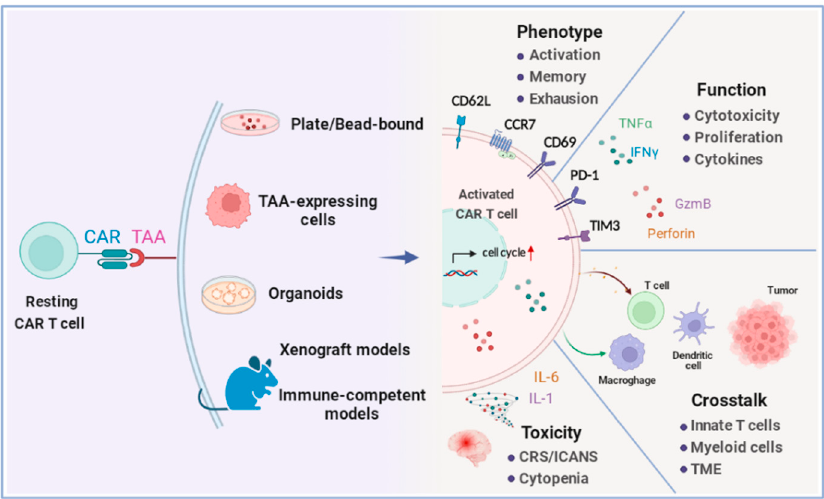
Figure 1. Schematic of functional parameters on activated CAR T cells.